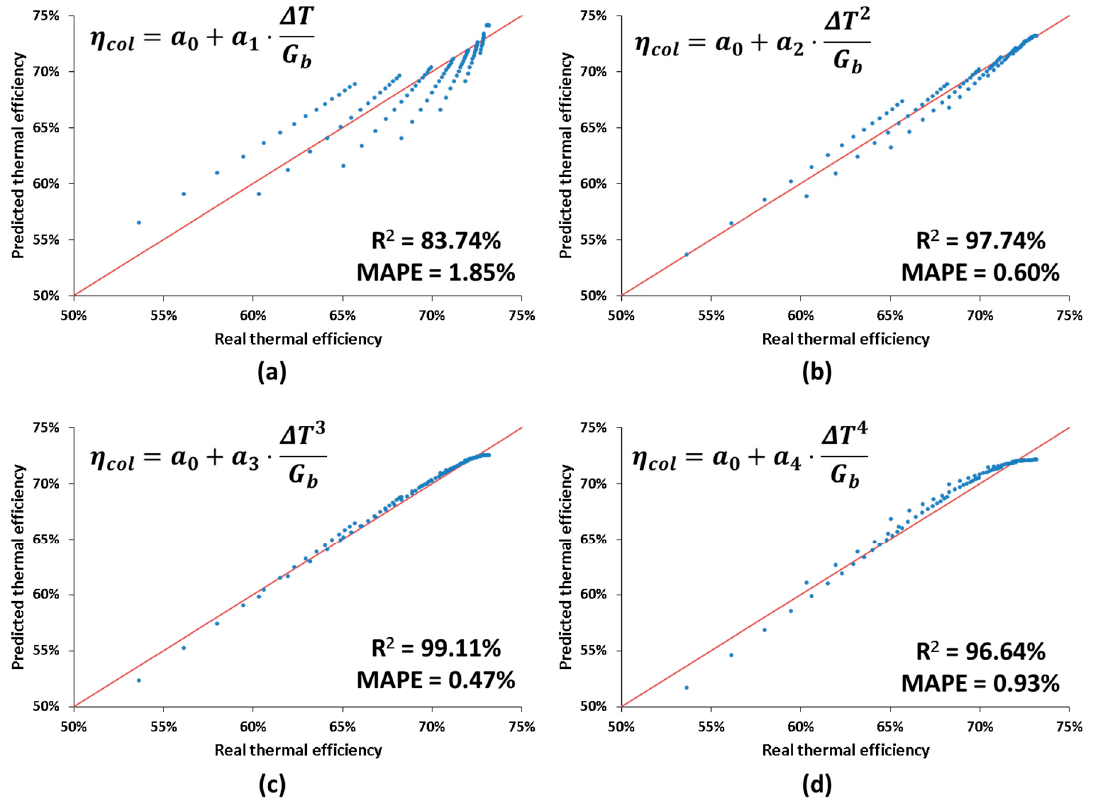
Figure 3. Evaluation of the thermal efficiency equations of the form “ a 0 + a m ∙ Δ T m / G b ” ( a ) [ a 0 , a 1 ] ( b ) [ a 0 , a 2 ] ( c ) [ a 0 , a 3 ] ( d ) [ a 0 , a 4 ]